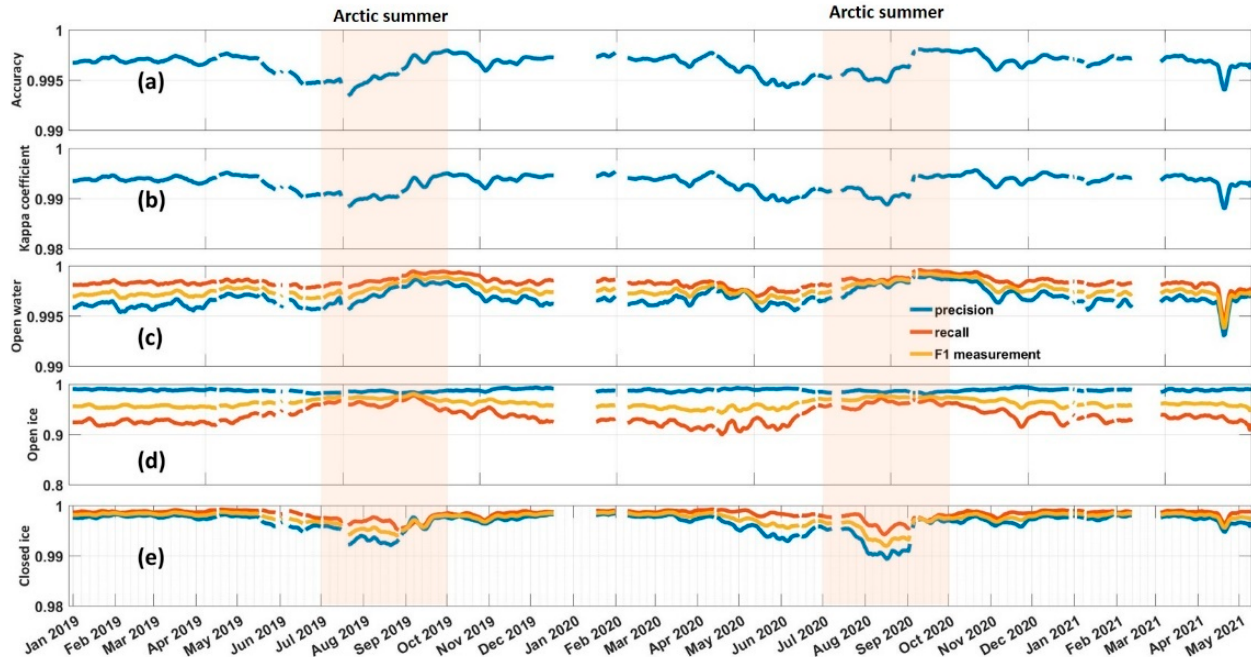
Figure 8. The time series of the evaluation parameters of the sea ice monitoring training model in the Arctic from 1 January 2019 through 10 May 2021 for ( a ) the overall accuracy, ( b ) kappa coefficient, ( c ) open water, ( d ) open ice, and ( e ) closed ice, respectively.